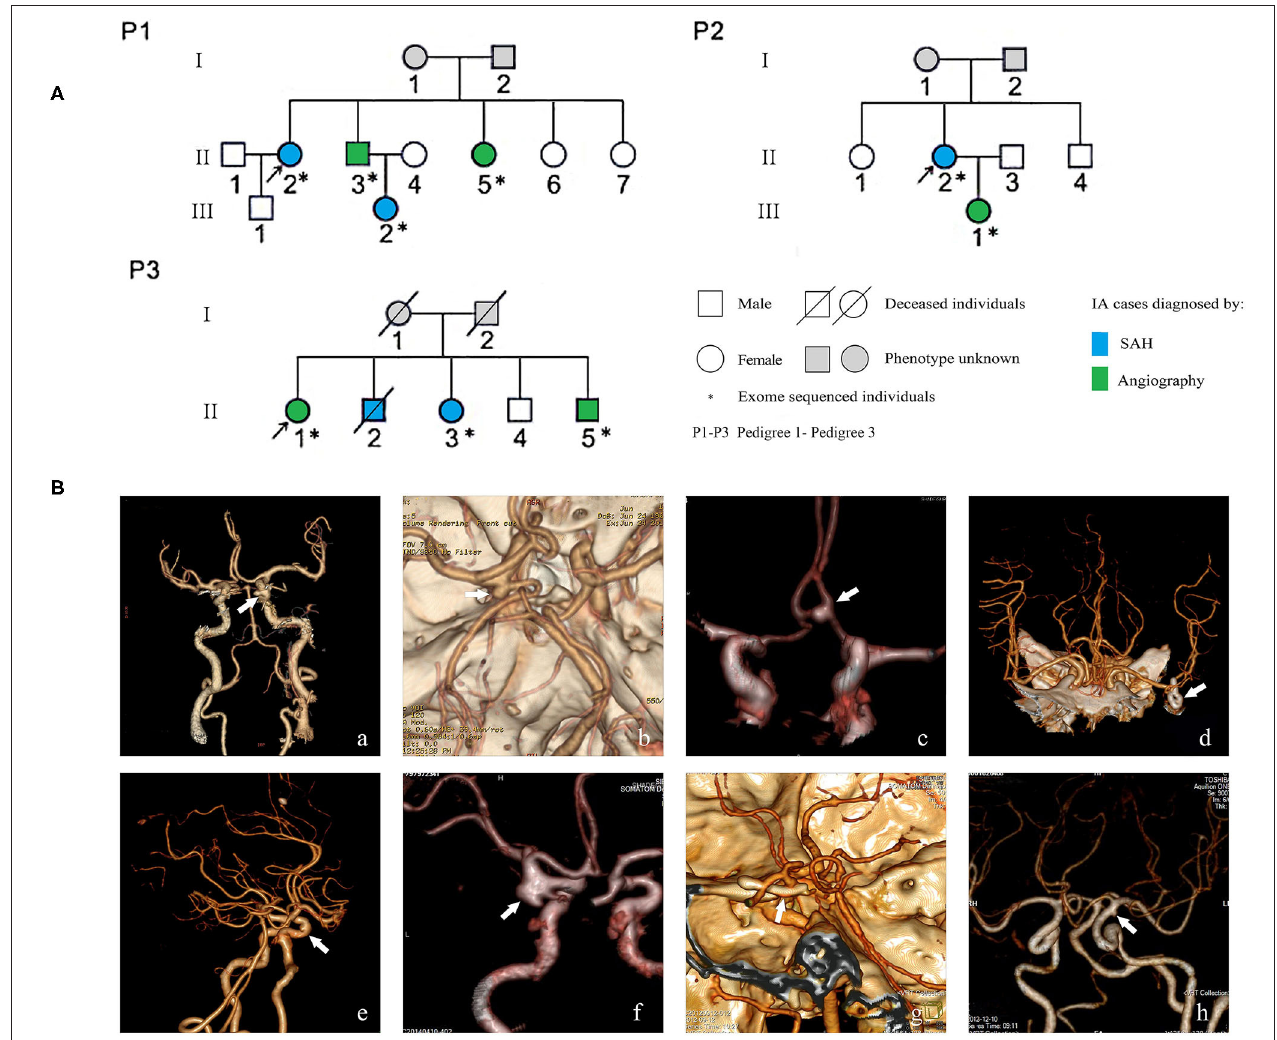
FIGURE 1 | Pedigrees of three Chinese intracranial aneurysm (IA) families (A) and angiographic images of eight familial IA patients (B) . SAH indicates subarachnoid hemorrhage; white arrows in the images of computer tomography angiography point to the locations of IAs. The digital image of patient P1-II-3 was not available because the patient was transferred to Xiangya Hospital; beforehand, his examination and surgery, which confirmed his diagnosis of IA, were performed in a different